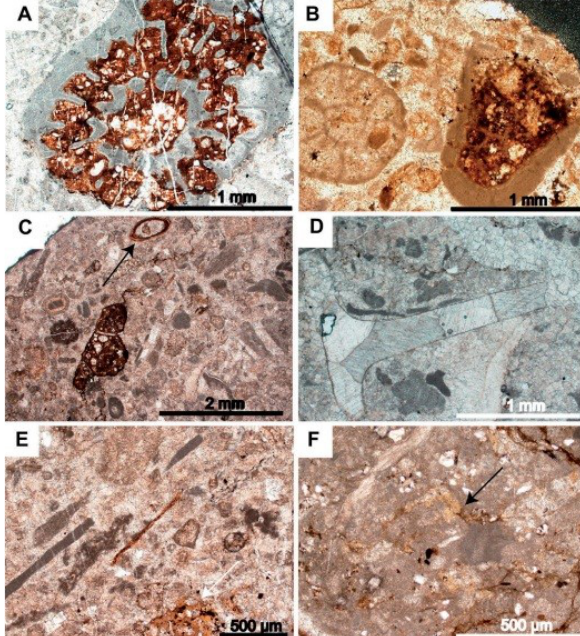
Fig. 9. Petrographic images of thin sections. All thinsections were made from the same hand samples as those used for dissolutions. A) Apatite filling a calcareous archaeocyath. B) Calcareous archaeocyath (left) and calcareous archaeocyath filled with apatite (right). C) Phosphatized hyolithid (black arrow). D) Calcareous small shelly fossil. E) Possible phosphatic brachiopod shell in the center of the picture, and phosphatic cement (white arrow). F) Glauconitic cement (black arrow). (after Pruss et al., 2017). Lower Cambrian, Salaanygol Formation.